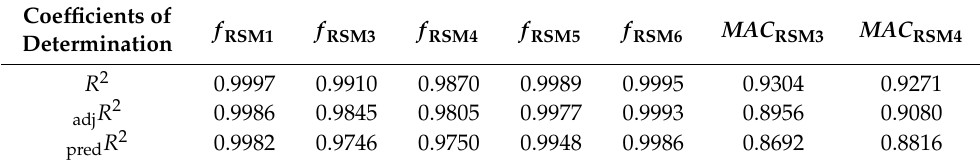
Table 11. Summary of coefficients of determination. RSM—response surface